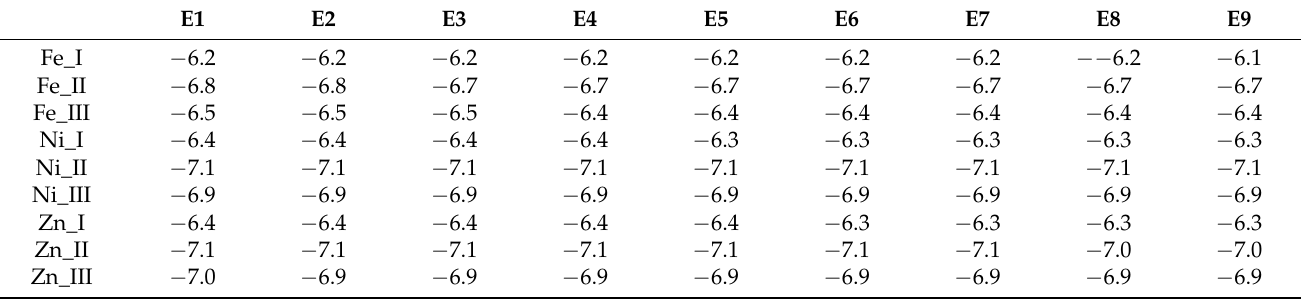
Table 13. Binding affinity for metal-phthalocyanines with C 46 N 3 P 3 (A) for nine conformations